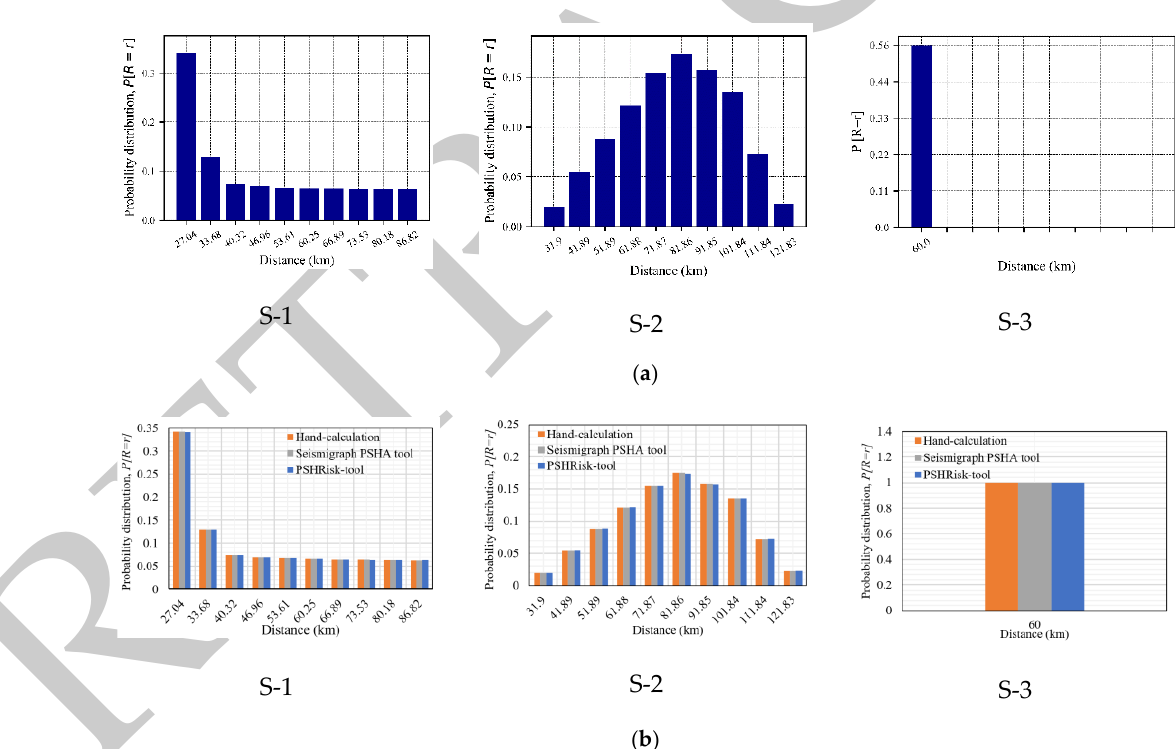
Figure 6. Verification for the probability distribution of distance, ( a ) PSHRisk-tool view, ( b ) Comparison.